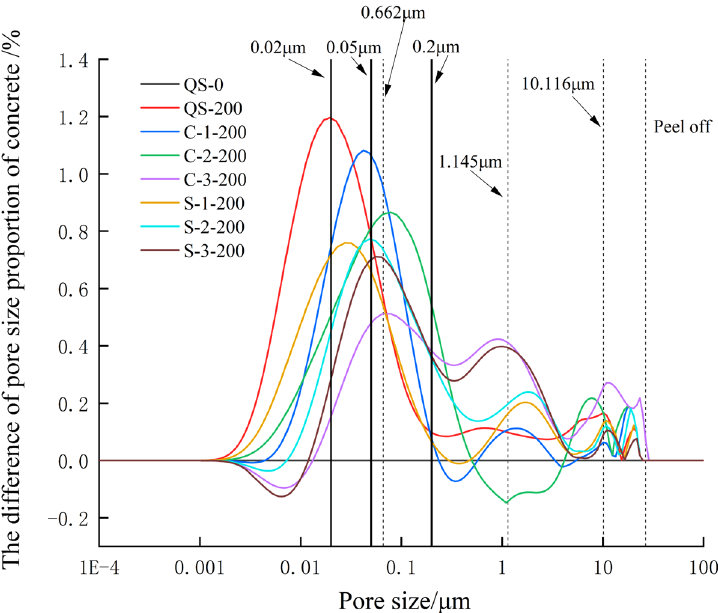
Figure 9: Di ff erence of pore size proportion of concrete after freezing and thawing